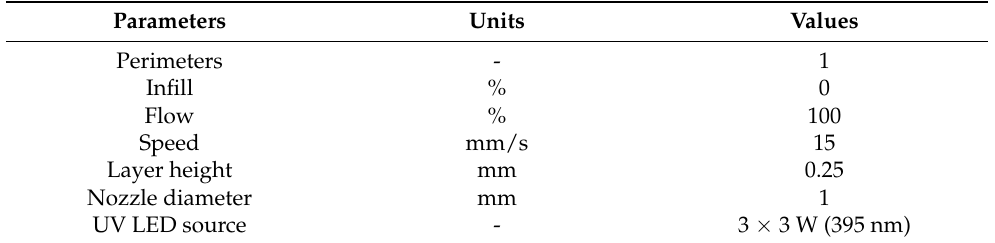
Table 1. Three-dimensional printing parameters of the samples for the surface characterization. Parameters Units Values Perimeters - 1 Infill %